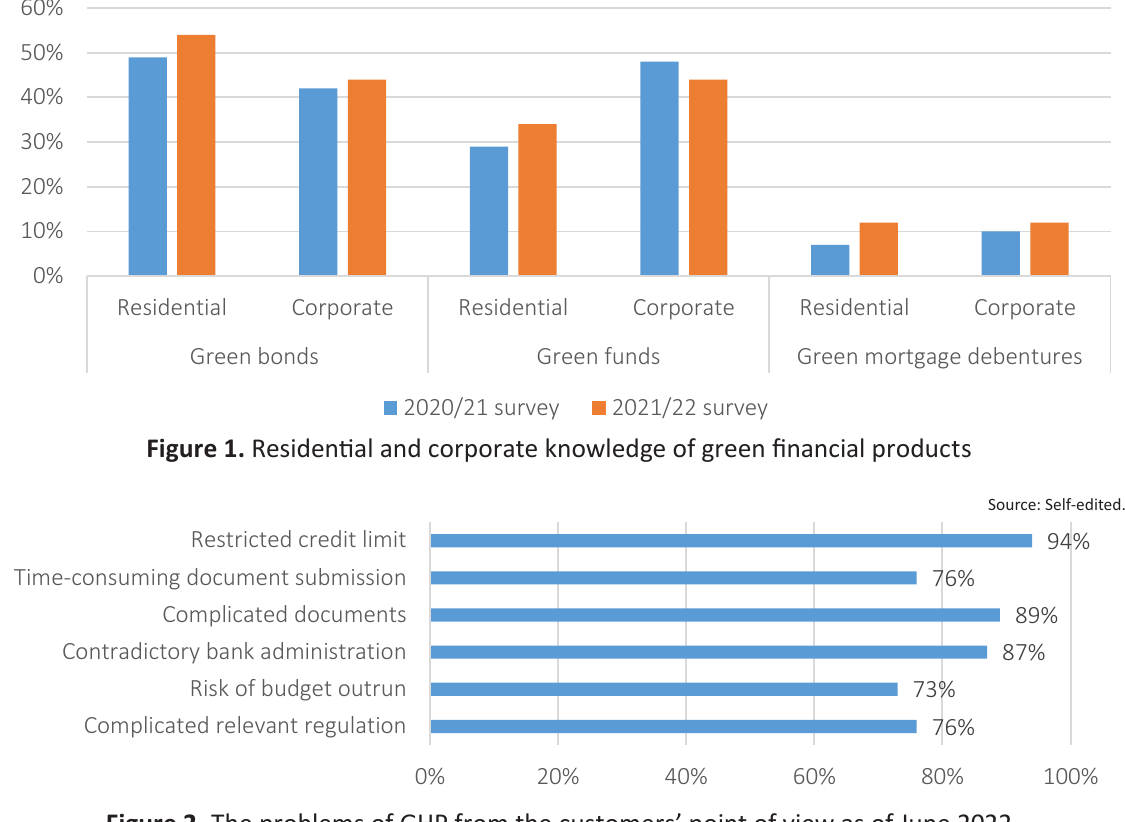
Figure 2. The problems of GHP from the customers’ point of view as of June